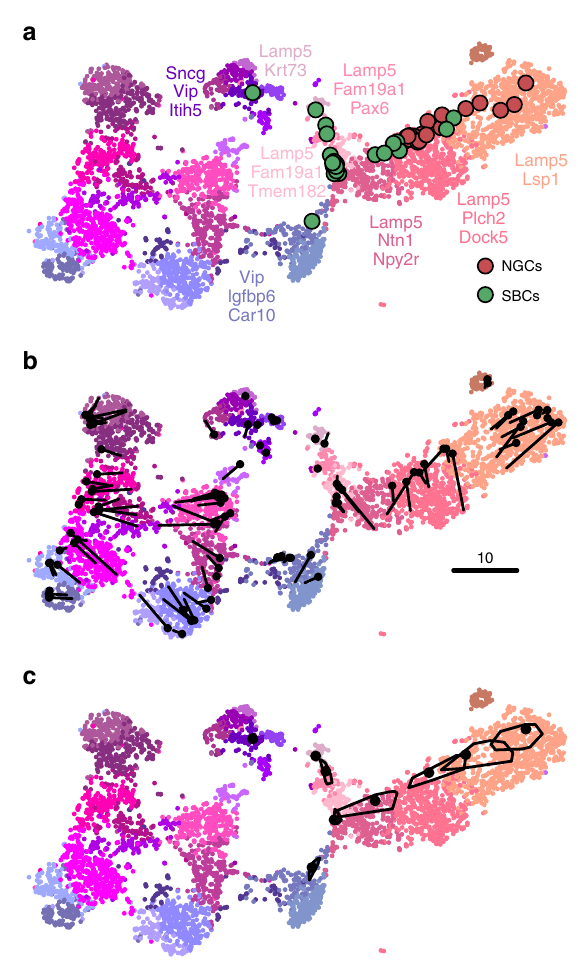
Fig. 5 Out-of-sample mapping. a Interneurons from ref. 27 positioned on the reference t-SNE atlas 3 from Fig. 2f. Only Vip/Lamp5 continent from Fig. 2f is shown here, as no cells mapped elsewhere. Cluster labels are given only for clusters where at least one cell mapped to. NGC neurogliaform cells; SBC single bouquet cells. Two cells out of 46 are not shown because they had an ambiguous class assignment. b A cross-validation approach: 100 random Vip/Lamp5 cells from the Tasic et al. data set were removed from the t-SNE embedding and then positioned back on it using our method. Black dots show new positions, black lines connect them to the original t- SNE locations of the same cells. c Positioning uncertainty for several exemplary cells from panel a . Polygons are convex hulls covering 95% of bootstrap